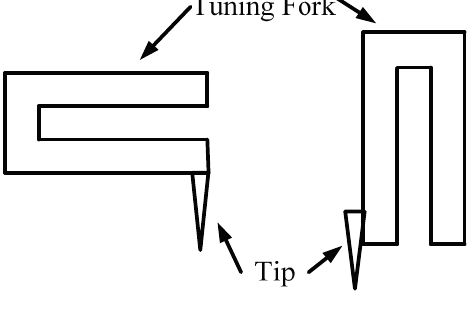
Figure 1. Typical tuning fork probe structures.